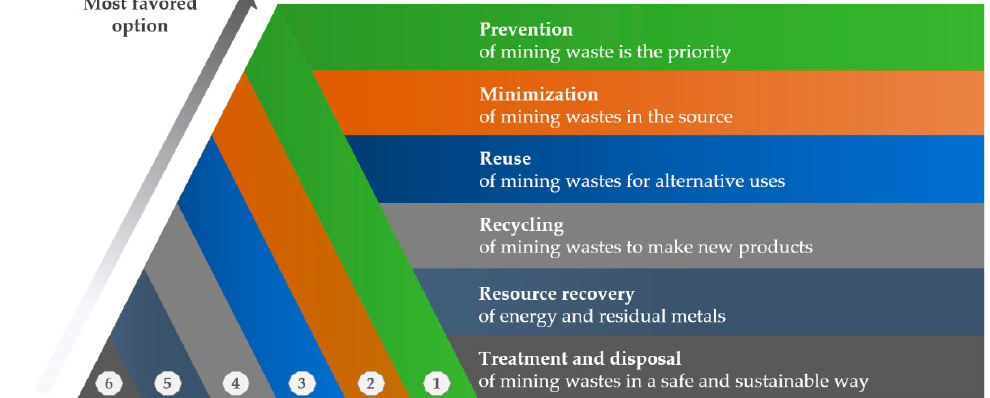
Figure 8. Waste management hierarchy from prevention to treatment and disposal.